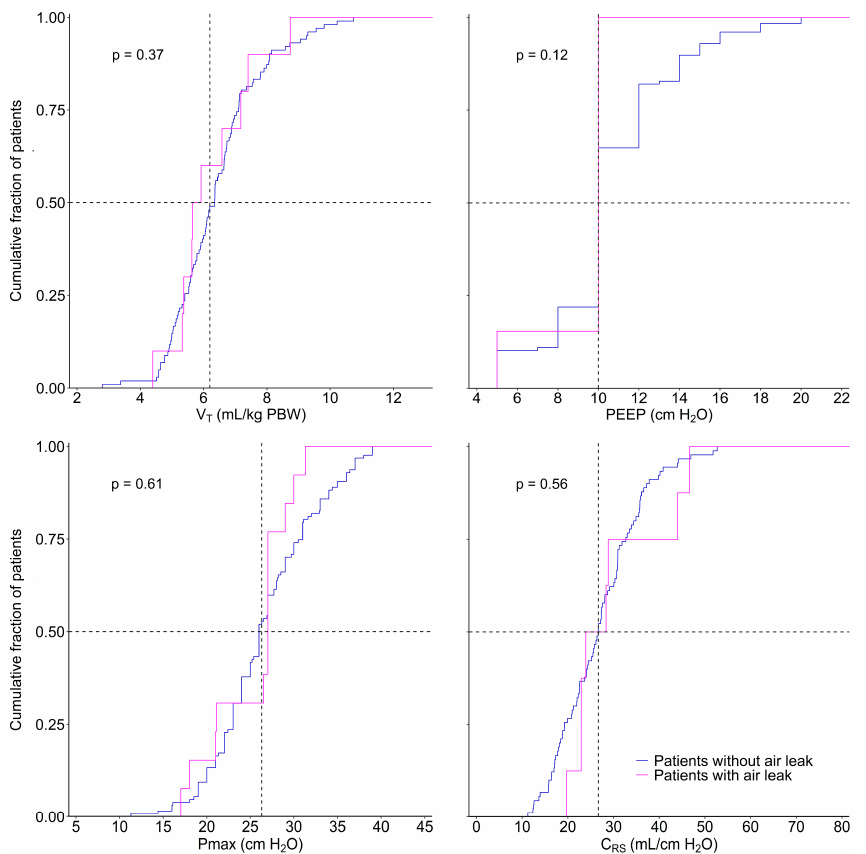
Figure 2. Key ventilation parameters. Cumulative frequency distribution of key ventilation parameters. Vertical dotted lines represent the median for each variable; horizontal dotted lines show the respective proportion of patients reaching the median. Abbreviations: VT—tidal volume; PEEP—positive end-expiratory pressure; Pmax—maximum airway pressure; and CRS—respiratory system compliance. Table 1. Demographics and Baseline Characteristics.